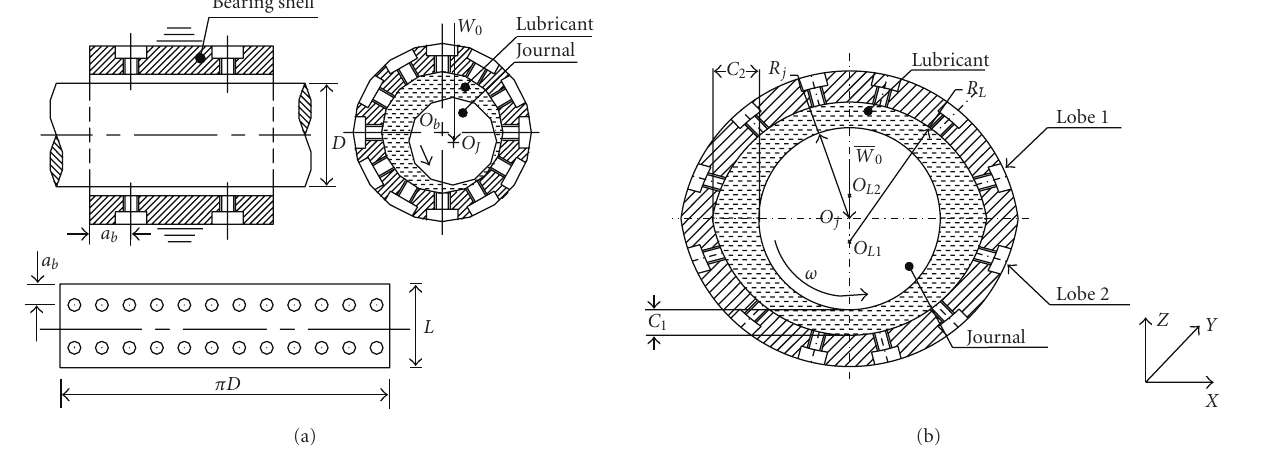
Figure 1: (a) Hole-entry type journal bearing system (symmetric configuration). (b) Two-lobe hole-entry type journal bearing system (symmetric